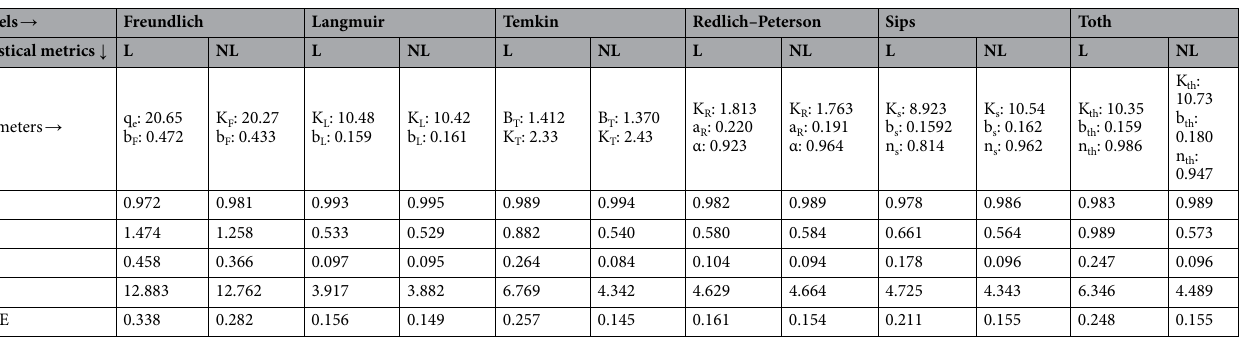
Table 2. Isotherm models for adsorption of diazinon onto pumice*. *Linear (L); non-linear (NL). q i e , exp , q i e , pred are q e values of experimental and predicted values respectively. p is the number of parameters; n is the number of experimental runs. Units: Langmuir: K L (mg/g). b L (L/mg). Freundlich: K F (mg 1-(1/n) L (1/n) g -1 ) and b F is dimensionless. Temkin: K T (L/mg). b T (J/mol). Redlich – Peterson: K R (L/g) and a R (L/mg) nP and n R is dimensionless. Sips: K